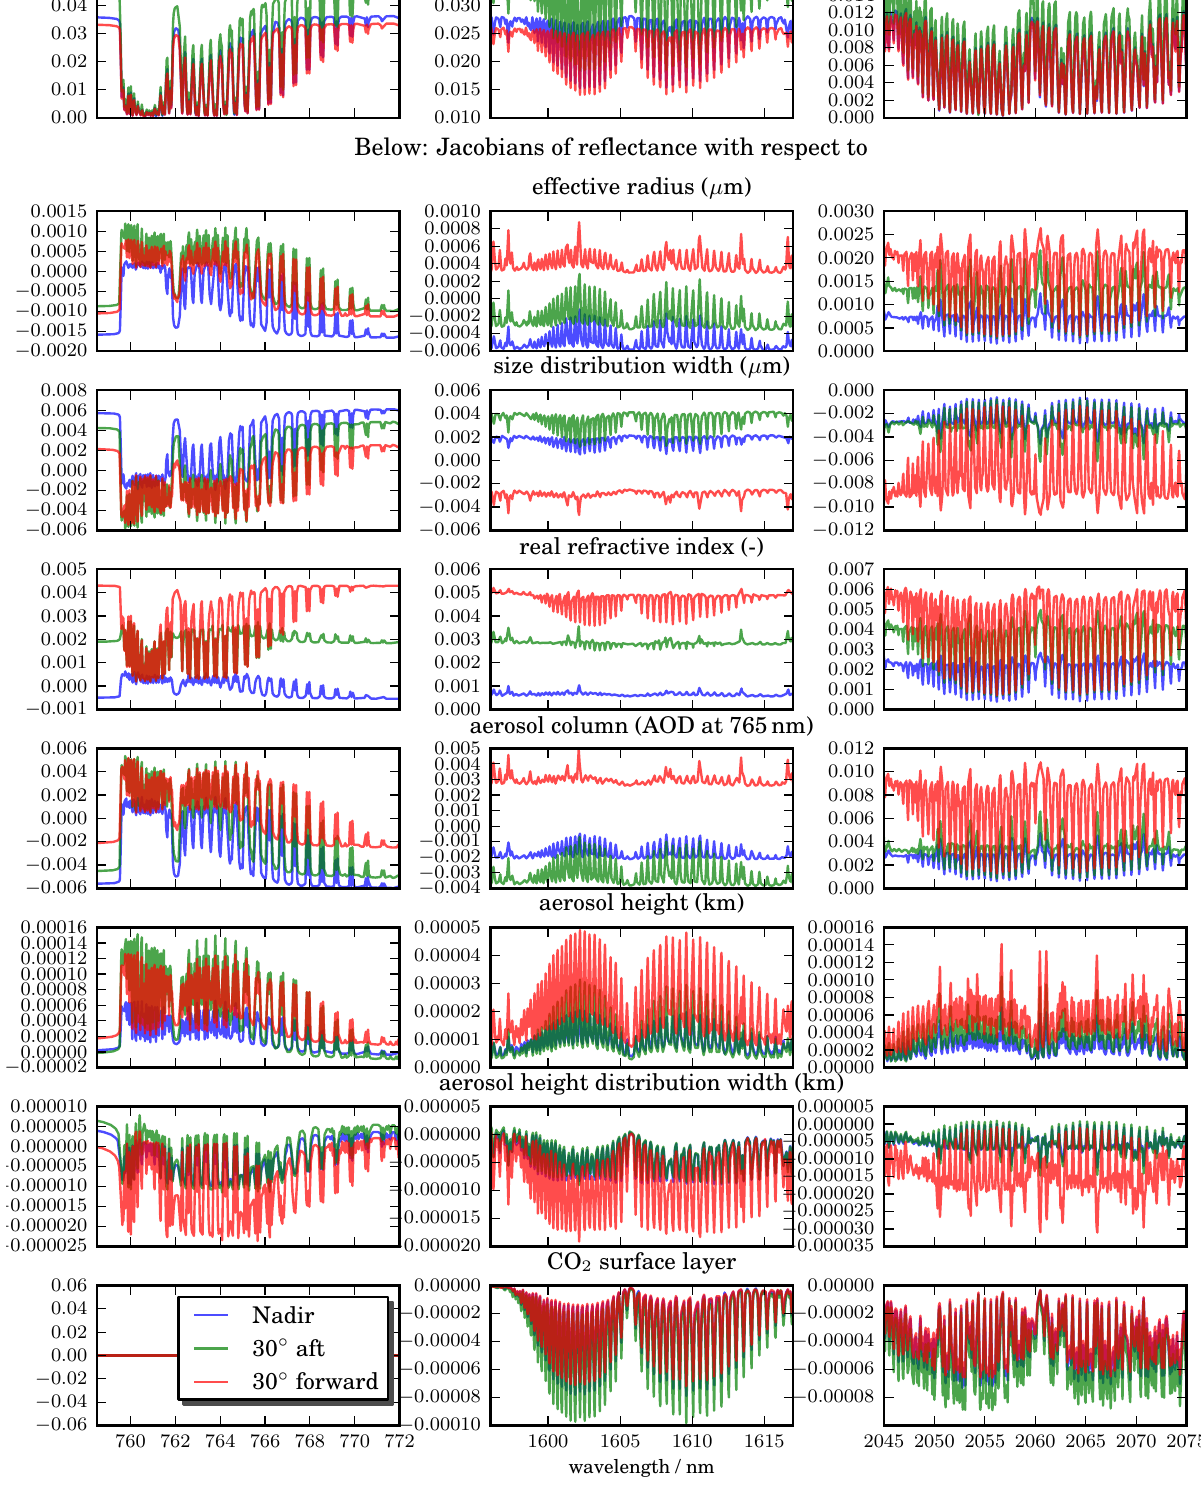
Fig. 2. Top panels: simulated spectral radiances at top-of-atmosphere for the O 2 A-band (left, 0.04nm FWHM), the weak CO 2 band (centre, 0.075nm FWHM) and the strong CO 2 band (right, 0.1nm FWHM) in the large SZA (65 ◦ ) case. Rows below: spectral Jacobians with respect to various aerosol microphysical, amount and vertical distribution properties. Bottom panels: Jacobian with respect to a change in CO 2 concentration near the